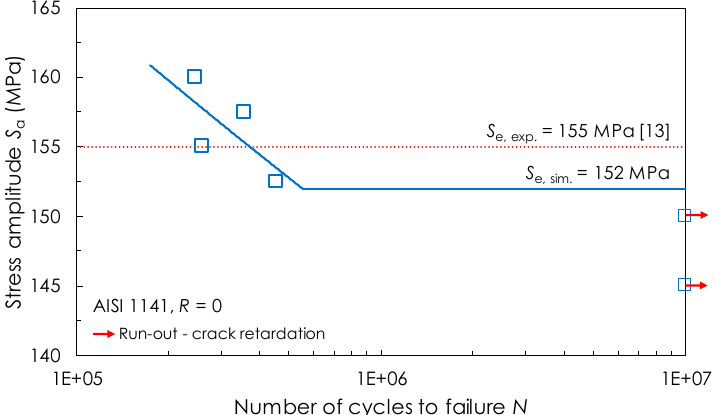
Figure 2. Comparison between simulated and experimental S e values for AISI 1141 steel [13]. For details on the numerical determination of S e values, see [5,16,17].